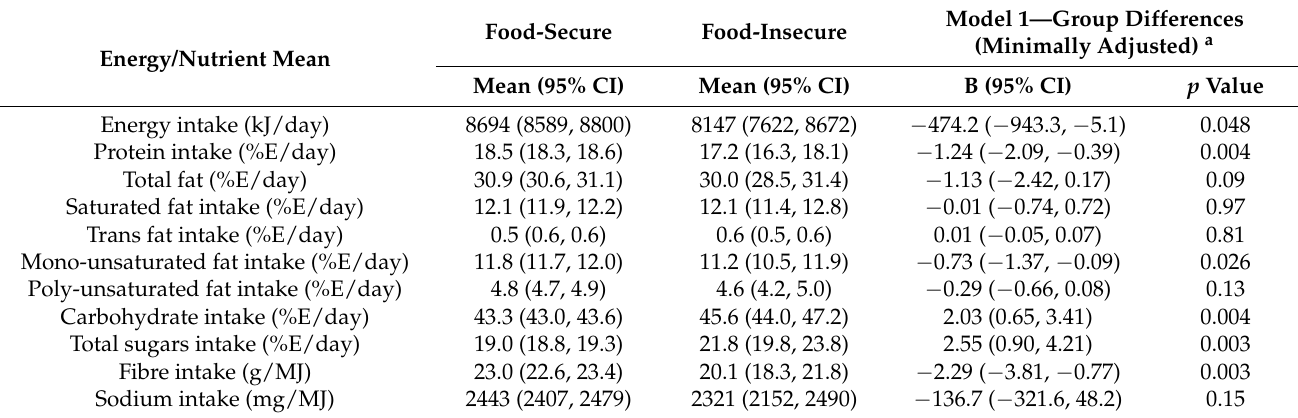
Table 3. Total energy and nutrient intakes of adults by food security